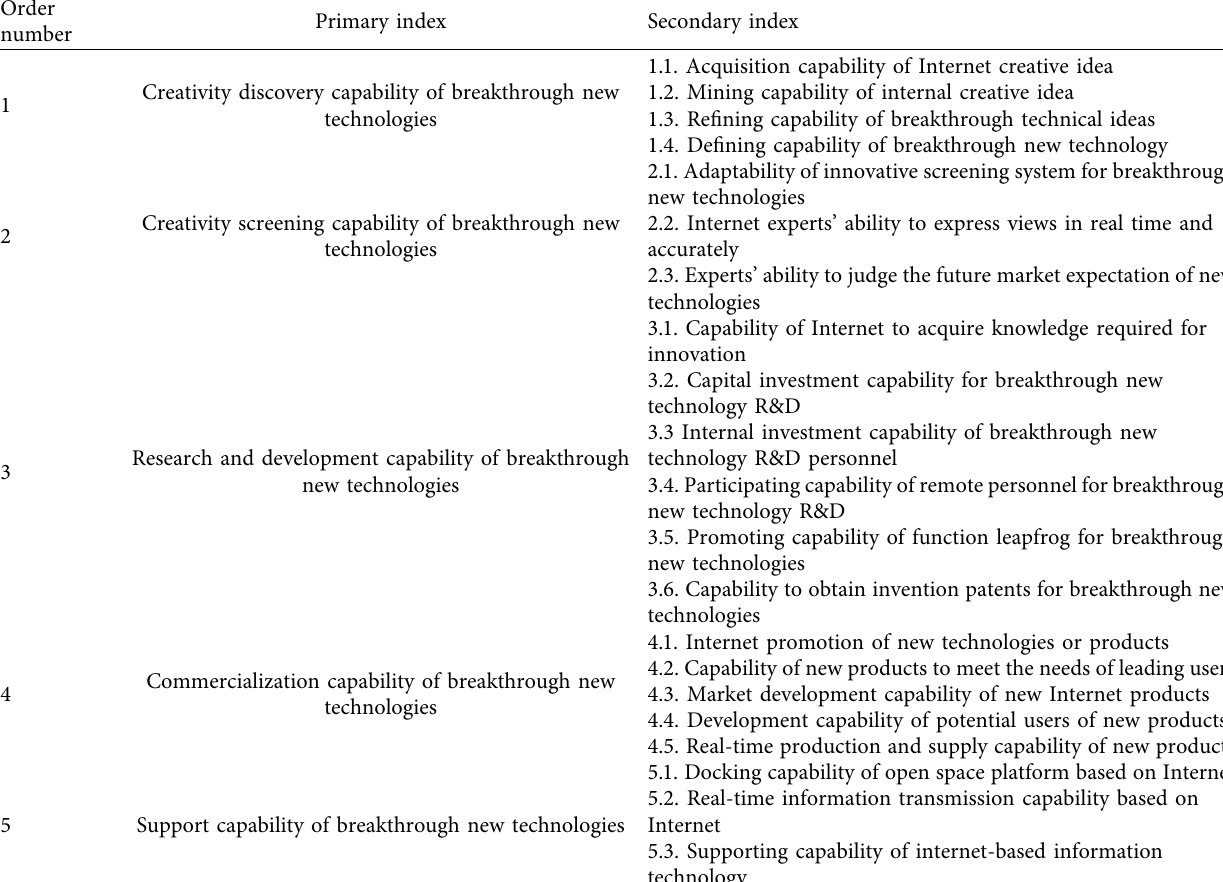
Table 1: Index system for BTIC of petroleum equipment manufacturing